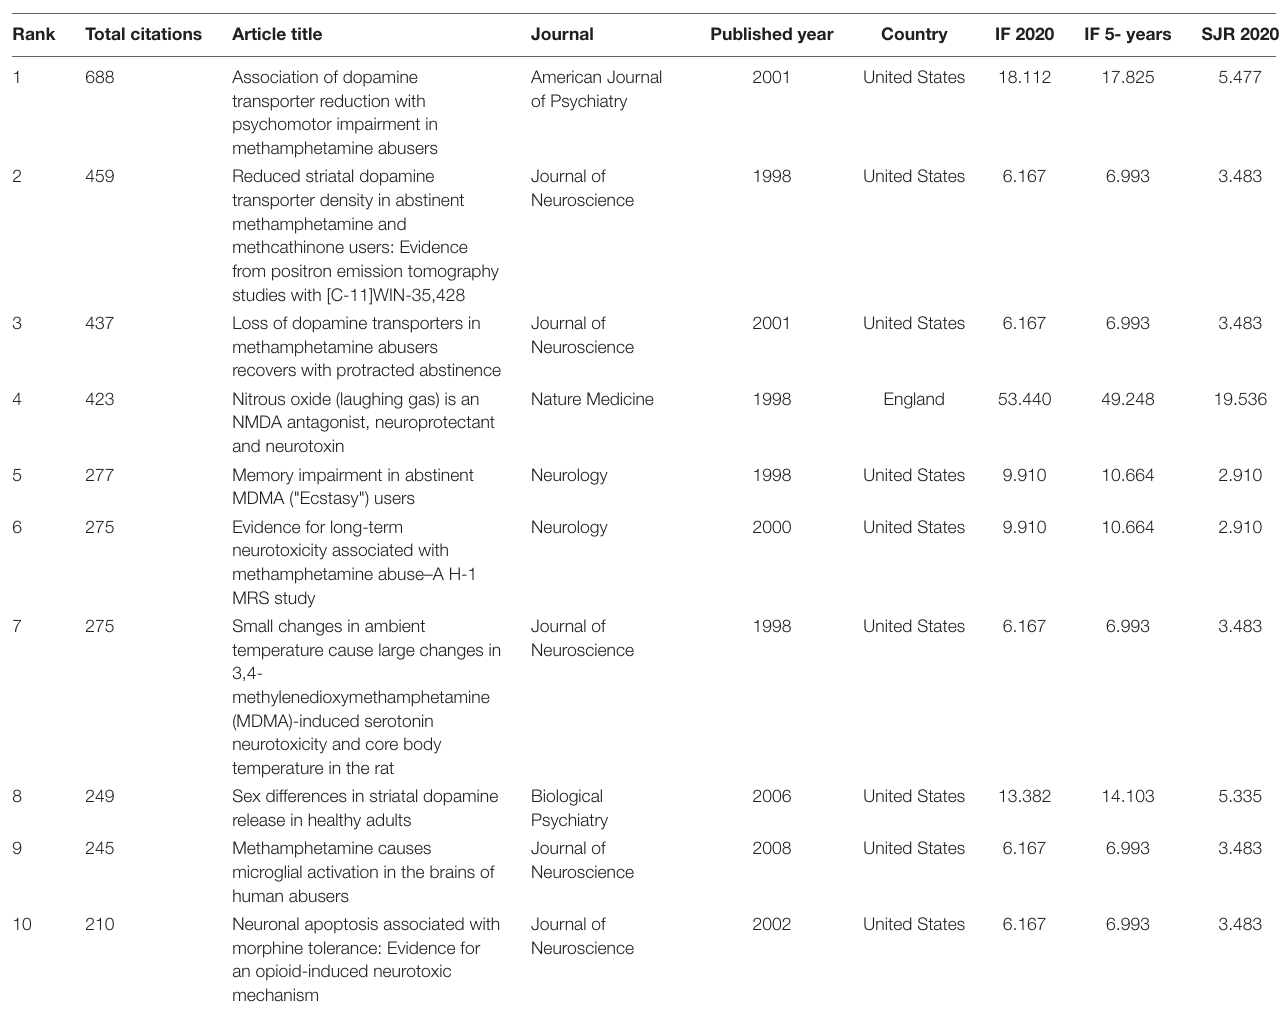
TABLE 2 | The characteristics of highly cited